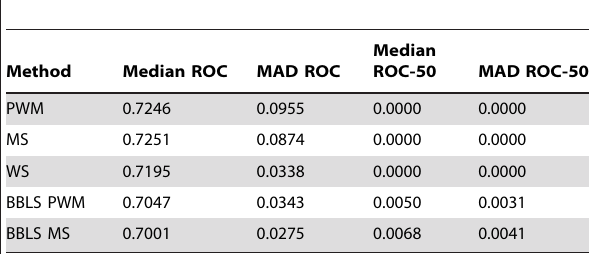
Table 4. Median and median absolute deviation (MAD) ROC scores on promoter